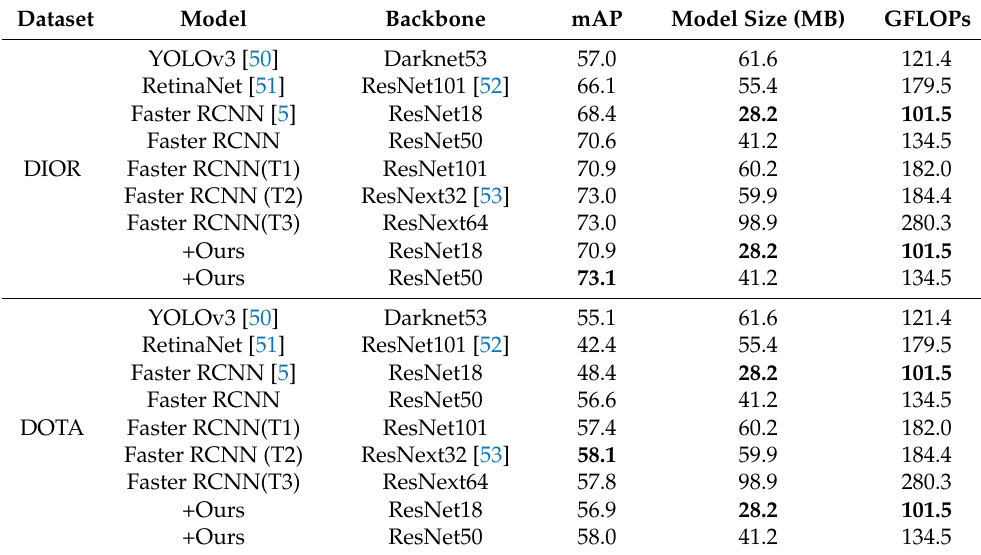
Table 1. Comparison of performance on the DIOR dataset and DOTA dataset. The best results are marked by bold text. T indicates the teacher